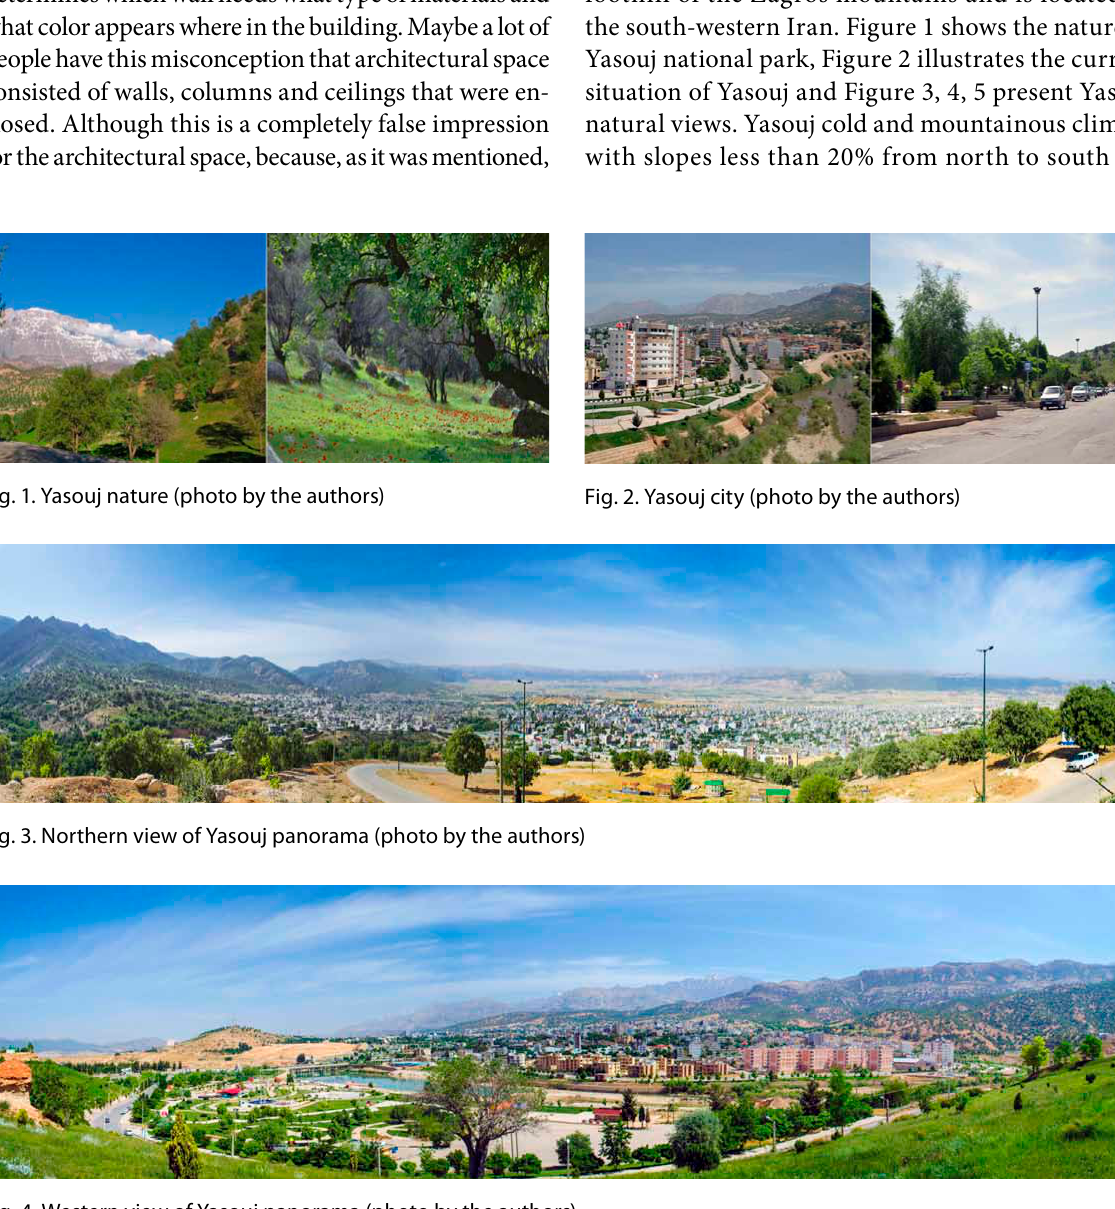
fig. 4. Western view of Yasouj panorama (photo by the